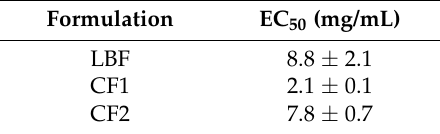
Table 5. Half maximal effective concentrations (EC 50 ) from dose-response